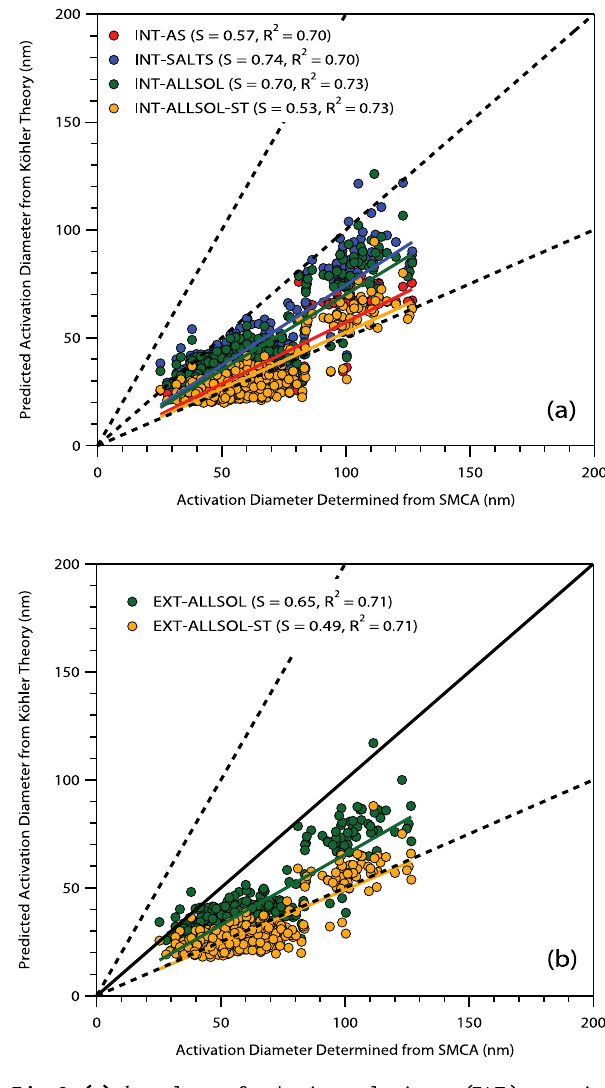
Fig. 6. (a) d p , c closure for the internal mixture (INT) scenarios. The red, blue, green, and yellow circles correspond to the INT-AS, INT-SALTS, INT-ALLSOL, and INT-ALLSOL-ST cases (Table 1), respectively. (b) d p , c closure for the external mixture (EXT) scenar- ios. The green and yellow circles correspond to the EXT-ALLSOL, and EXT-ALLSOL-ST cases (Table 1), respectively. Dashed lines represent 1:2 and 2:1 prediction